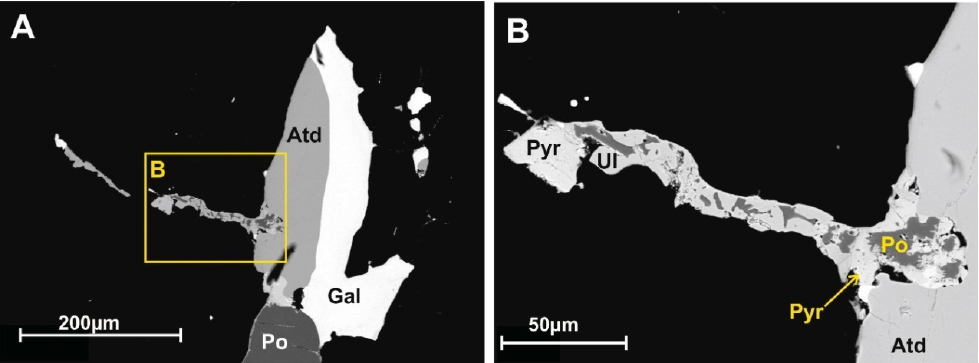
Figure 14. Aggregate of ulmannite (Ul), pyrrhotite (Po), and pyrargyrite (Pyr) at the boundary of argentotetrahedrite (Atd) grain: ( A ) general view, ( B ) detailed area. Back scattered electron images (BEI).